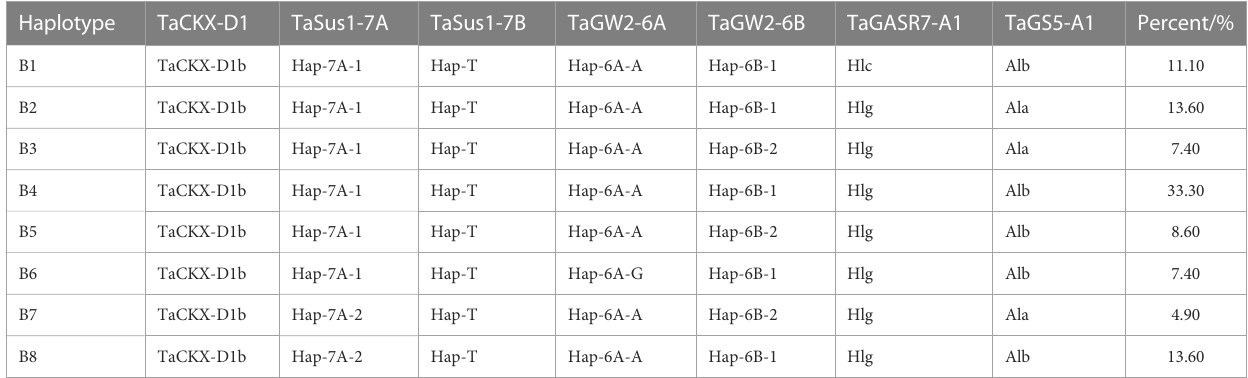
Table 3. The physicochemical properties of the various soil layers are listed in Supplementary Table 4. TABLE 2 Allelic combinations for kernel weight (B, eight